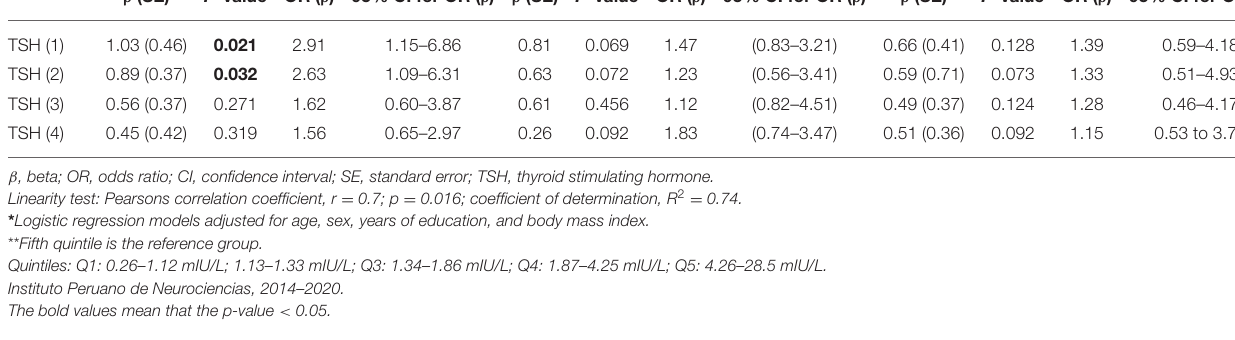
TABLE 5 | Demographic, clinical, and cognitive characteristics of participants with normal levels of vitamin B12 and vitamin B12 deficiency*. Characteristic Vitamin B12